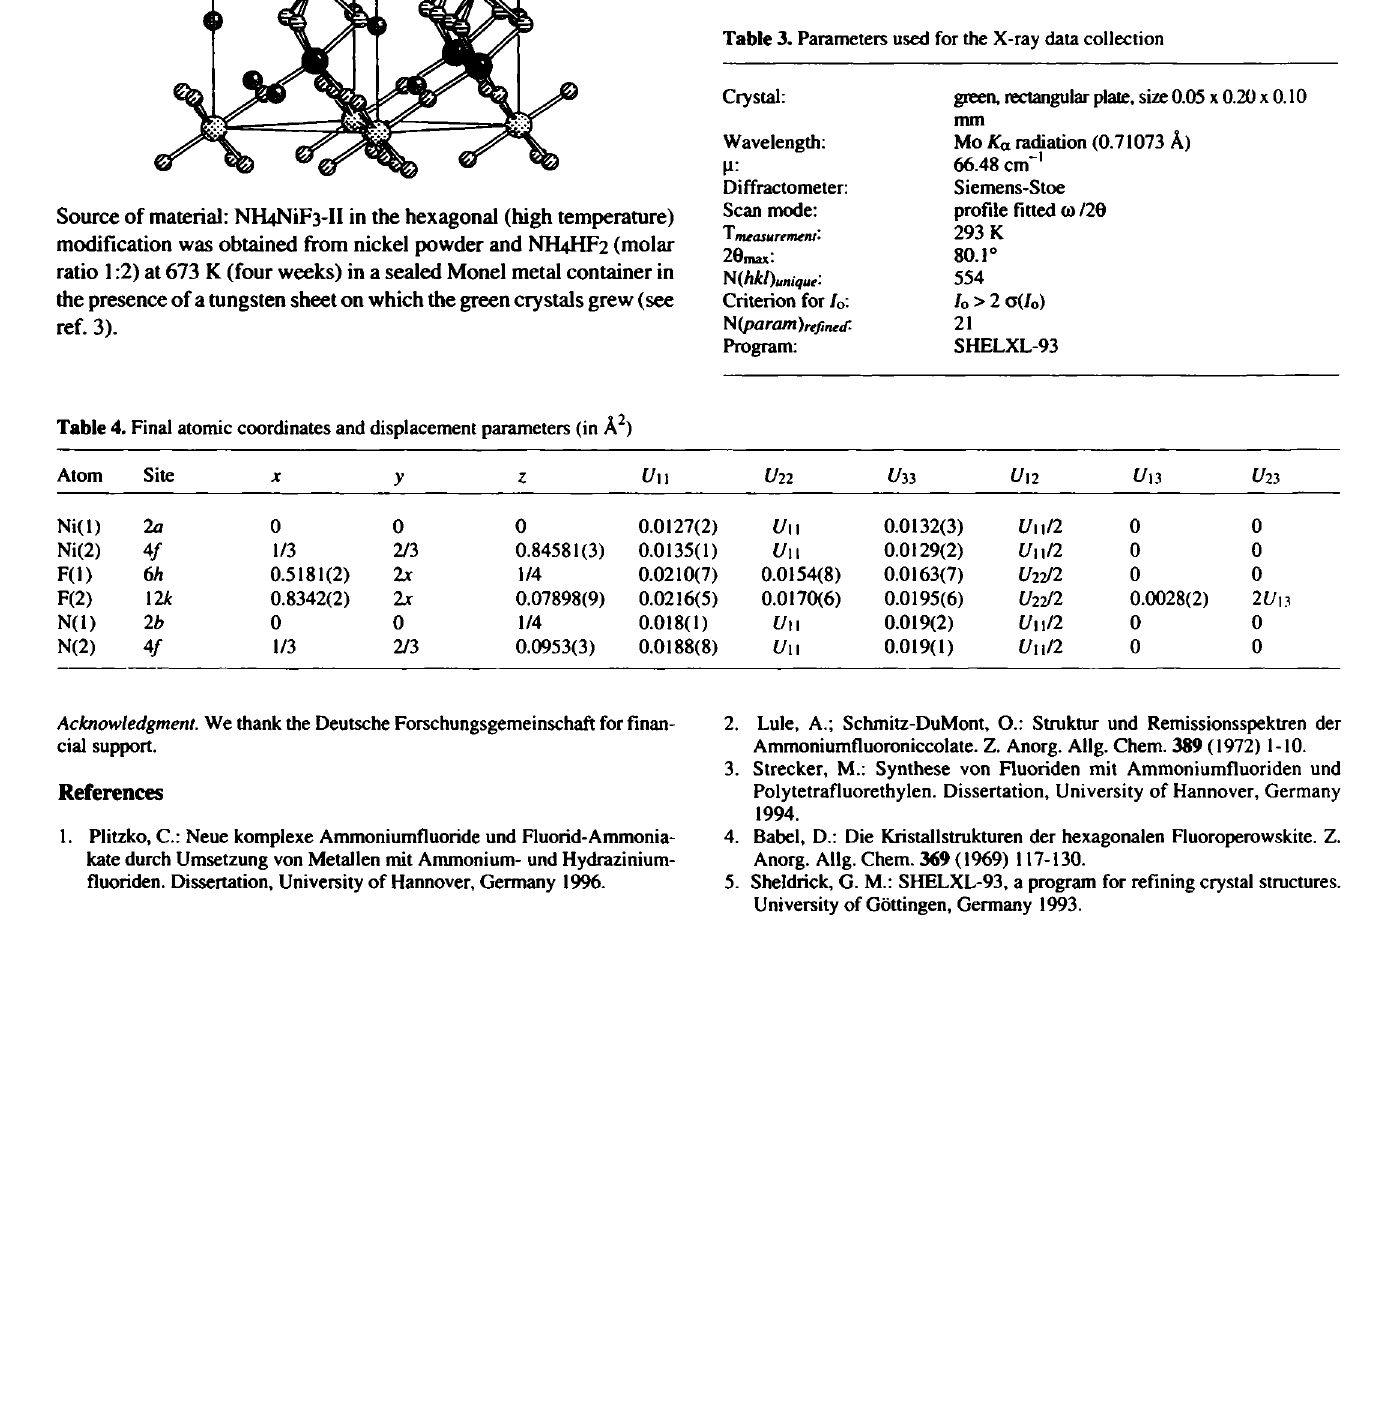
Table 3. Parameters used for the X-ray data collection